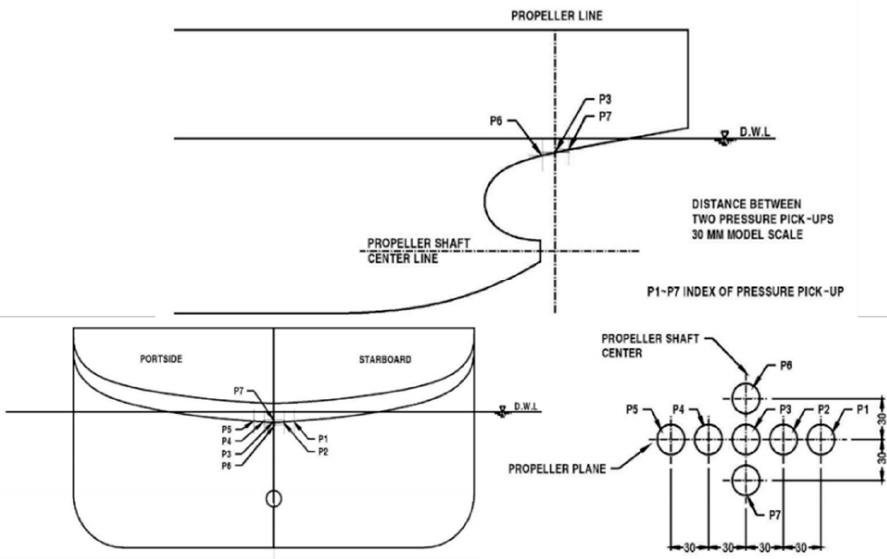
Figure 17. Position of the pressure transducers on the hull surface.